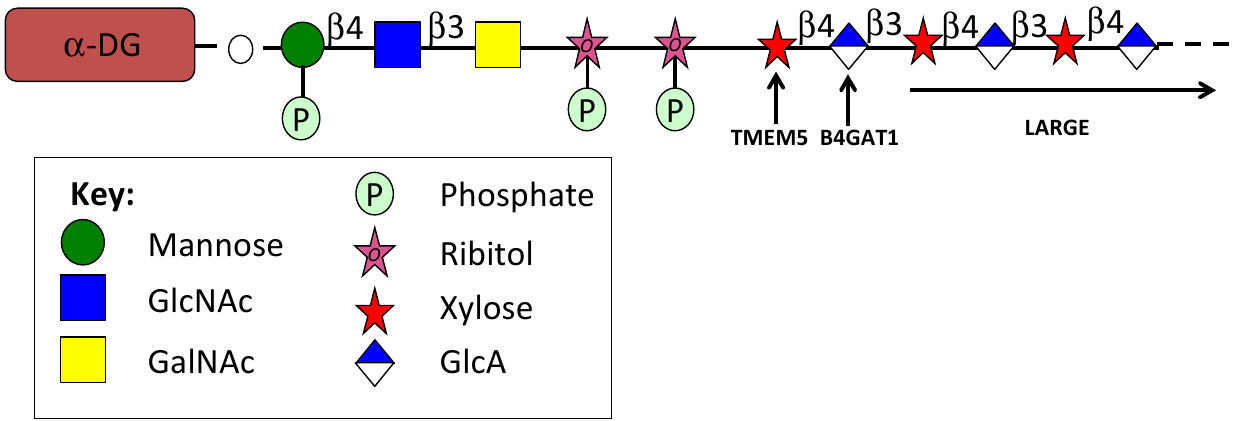
Figure 7. The α -DG LamG binding receptor and its constituent glycan components assembled from a GalNAc- β 3-GlcNAc β 4 Mannose M3 trisaccharide link module with sequential attachment of a number of glycan components by glycosyl transferases including TMEM5, B4GAT1, and the LARGE xylosyl and glucuronyl transferase complex to form a functional receptor. Phosphorylated ribitol is an unusual component in this assembly process. Figure re-drawn from data provided in [407,409].